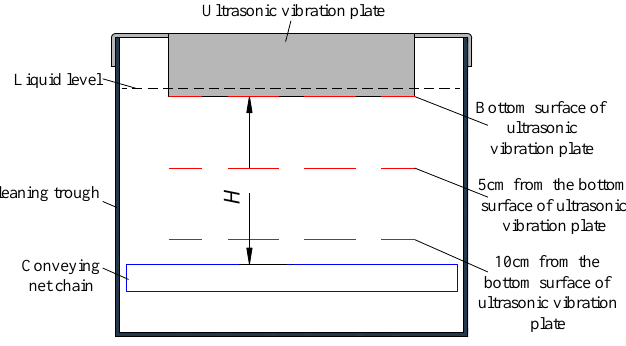
Figure 7. Schematic of position relationship of ultrasonic cleaning.